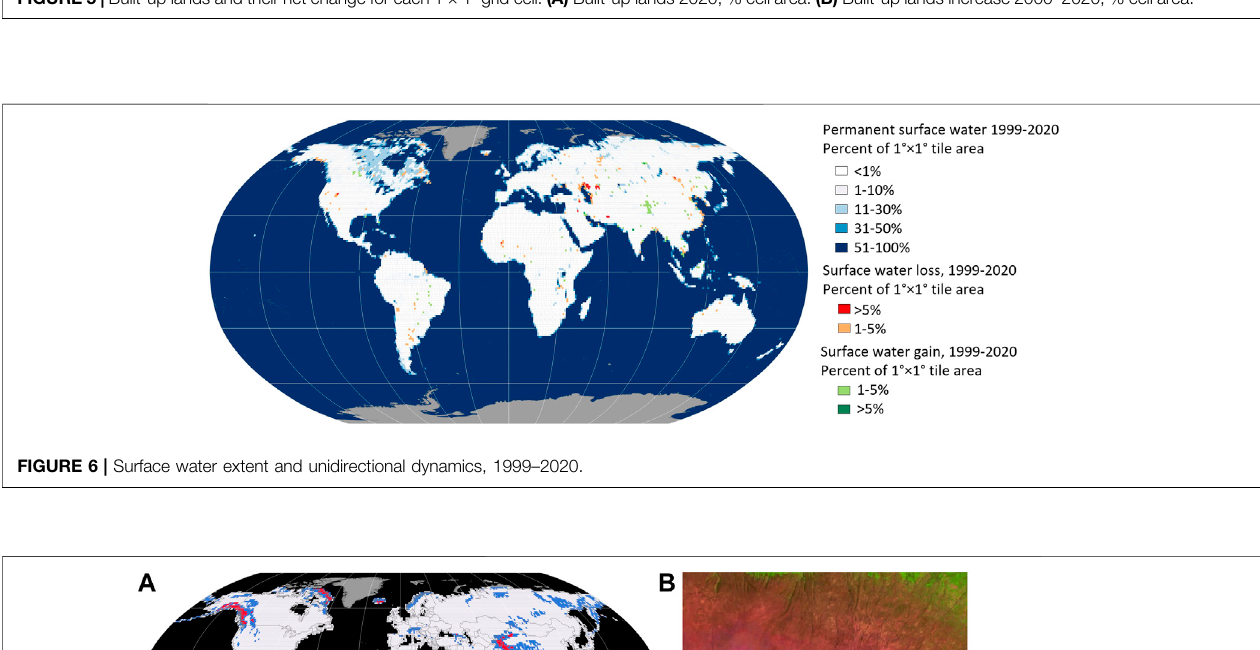
( Figure 6 ). China had the largest proportion of surface water gain (19% global total) due to the expansion of lakes on the Tibetan Plateau and creation of reservoirs by construction of dams.